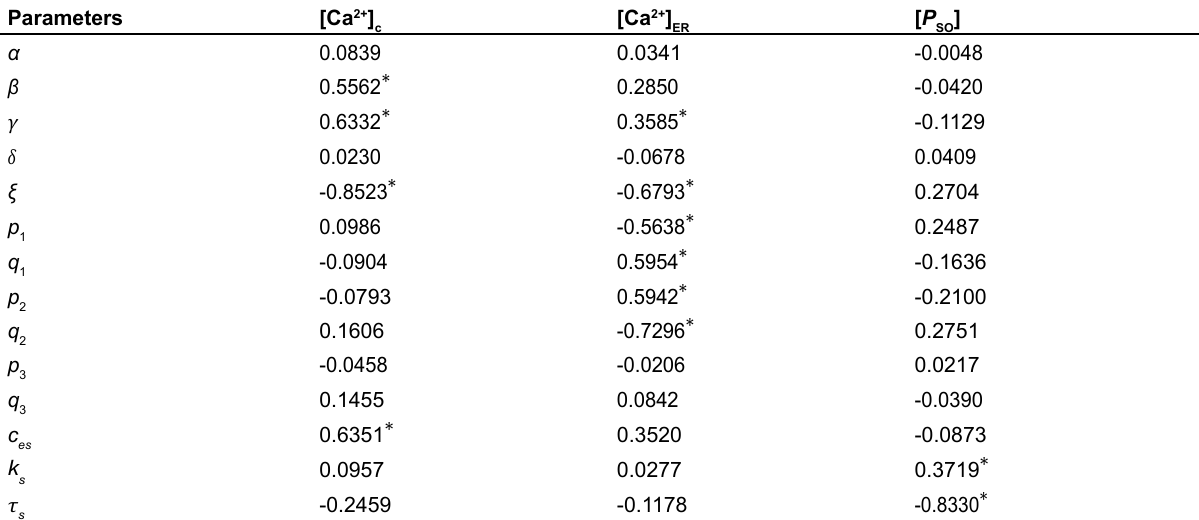
∗ Each parameter was sampled for 10 fold up and down from the baseline value and obtained sensitivity indexes using PRCC